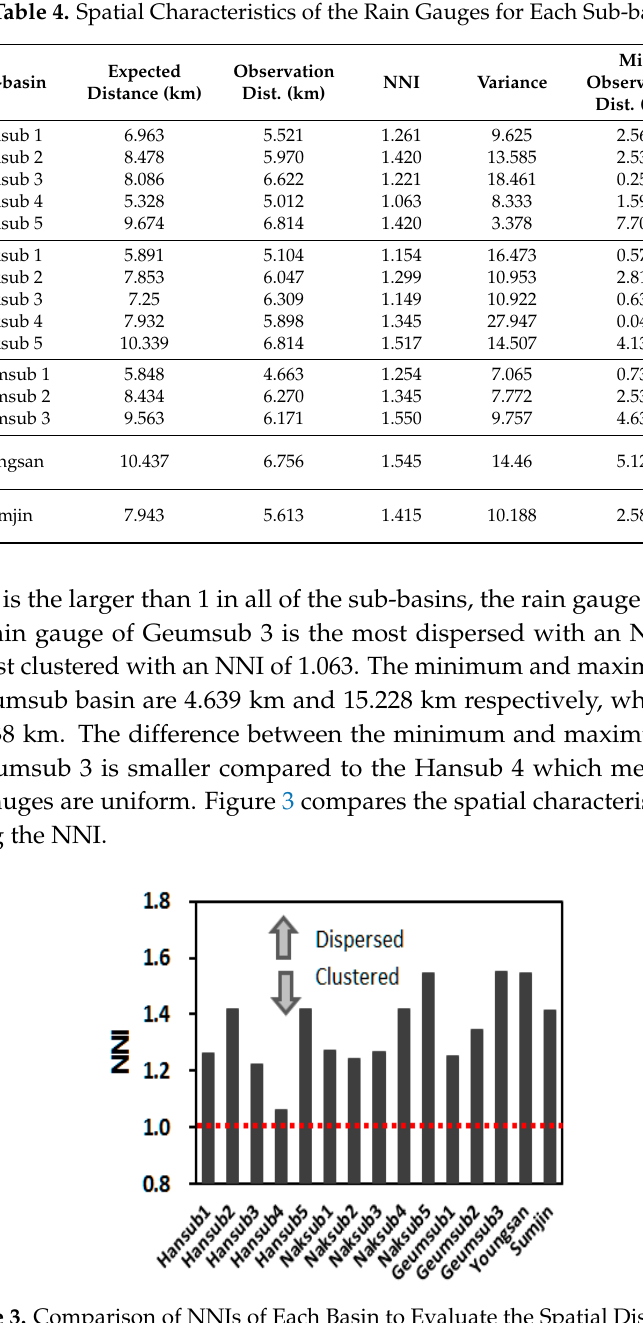
Figure 4. Spatial Distribution of Rain Gauge Network Based on NNI (Best and Worst Sub-basin). 4. Analysis of Estimation Error of the AAR 4.1. Selection of Rainfall Event for the Analysis To evaluate the characteristics of the spatial distribution of the rain gauges by each sub-basin, the estimation error of the AAR for the basins with the best spatial distribution (Geumsub 3) and the worst (Hansub 4) are estimated. For water resources plan, AAR estimates of long-term rainfall, such as daily, monthly and annual rainfall, are needed. However, for the purpose of flood mitigation, hourly rainfall is often required and measurements of hourly or even smaller duration rainfalls are necessary [5]. According to Cheng et al. [5], hourly rainfall exhibits higher variability in space and the spatial variation structures among different storm types, whereas annual rainfall is shown to exhibit a less spatial variability. In this study, AAR is not calculated for each type of rainfall because the rain gauge network should be considered the water resources planning and flood mitigation. However, radar correction is mainly aimed at predicting extreme rainfall, so it should be reviewed for each type of rainfall. To calculate the estimation error of the AAR, we collected the observed hourly rainfall data occurred (April 2005 to August 2014) in those basins. The applied rainfall data are converted to digital signals by the telemetering system at the rainfall station and transmitted to the data processing centre by the wireless communication network in real time. While the IETD (Inter Event Time Duration) used to separate the rainfall events is 12 h by assuming they are all natural watersheds, of the selected only the rainfall events that have a total rainfall amount of at least 30 mm and 5 h of rainfall duration are used. Using this as the standard, there are 87 rainfall events in the Geumsub 3 and 102 in the Hansub 4 as shown in Table 5.